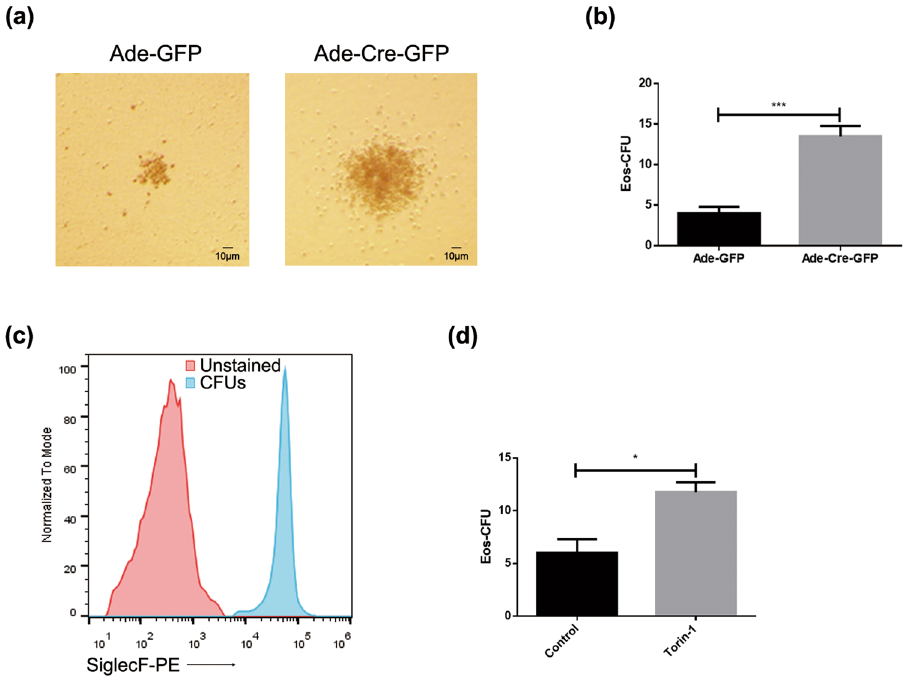
Figure 2. mTOR knockdown promotes IL-5-induced colony forming units. ( a ) 2 × 10 5 NAMNCs originated from Mtor flox/flox mice were seeded in methylcellulose-based semi-solid medium for colony formation in the presence of IL-5 (10 ng/ml). CFUs were calculated at day 7, and images were captured by microscope. ( b ) CFU numbers after adenoviral Cre recombinase expression. ( c ) CFUs were picked and washed by PBS, then stained with PE-conjugated SiglecF, representative histograms are shown. ( d ) Torin-1 (250 nM) was added in the medium before being seeded, and the number of CFUs were counted on day 7. All the results above were triplicated by three independent experiments and were analysed by Student’s T-test as means ± SEM. * P < 0.05, *** P <